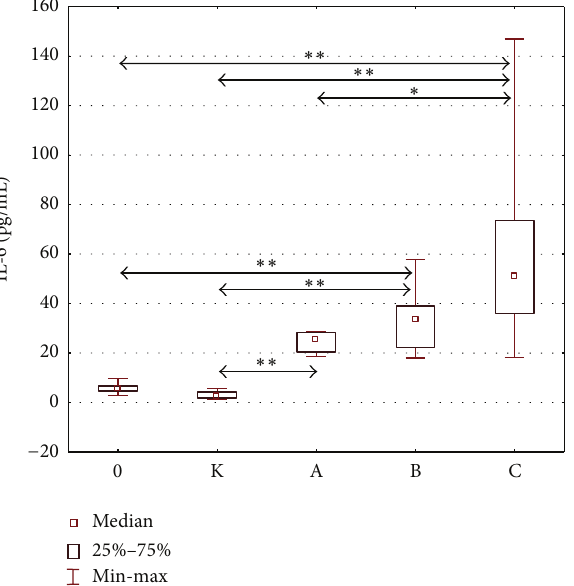
Figure 3: IL-6 concentration (pg/mL) in the serum of alcoholics without liver cirrhosis (0), alcoholics with liver cirrhosis (stages A, B, and C), and healthy controls (K). Key: ∗ 𝑝 < 0.05 and ∗∗ 𝑝 < 0.001